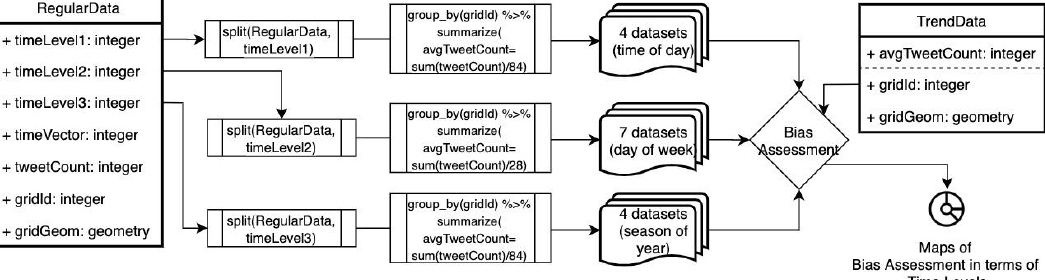
Figure 7. Bias assessment flow.